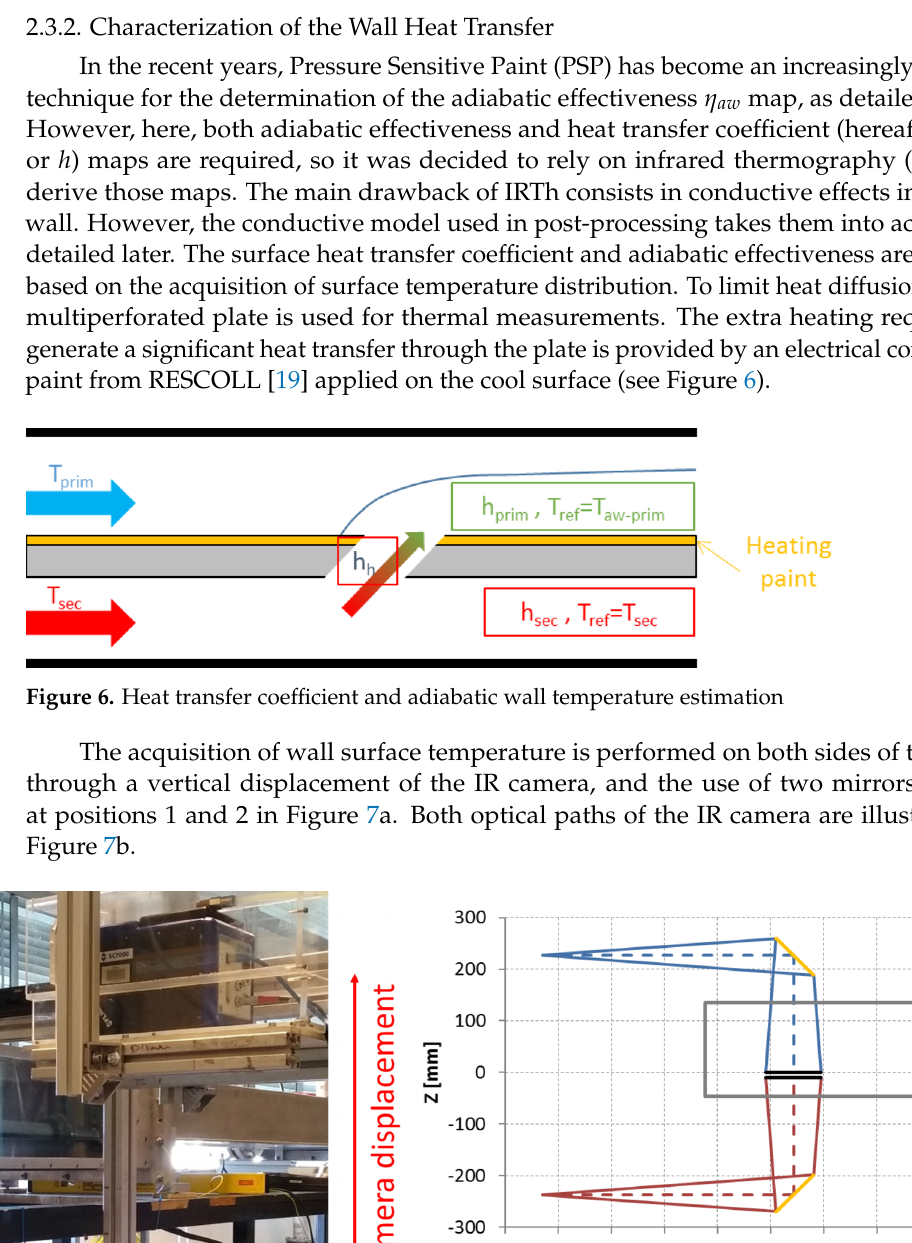
Figure 7. Infrared thermography set-up for wall heat transfer